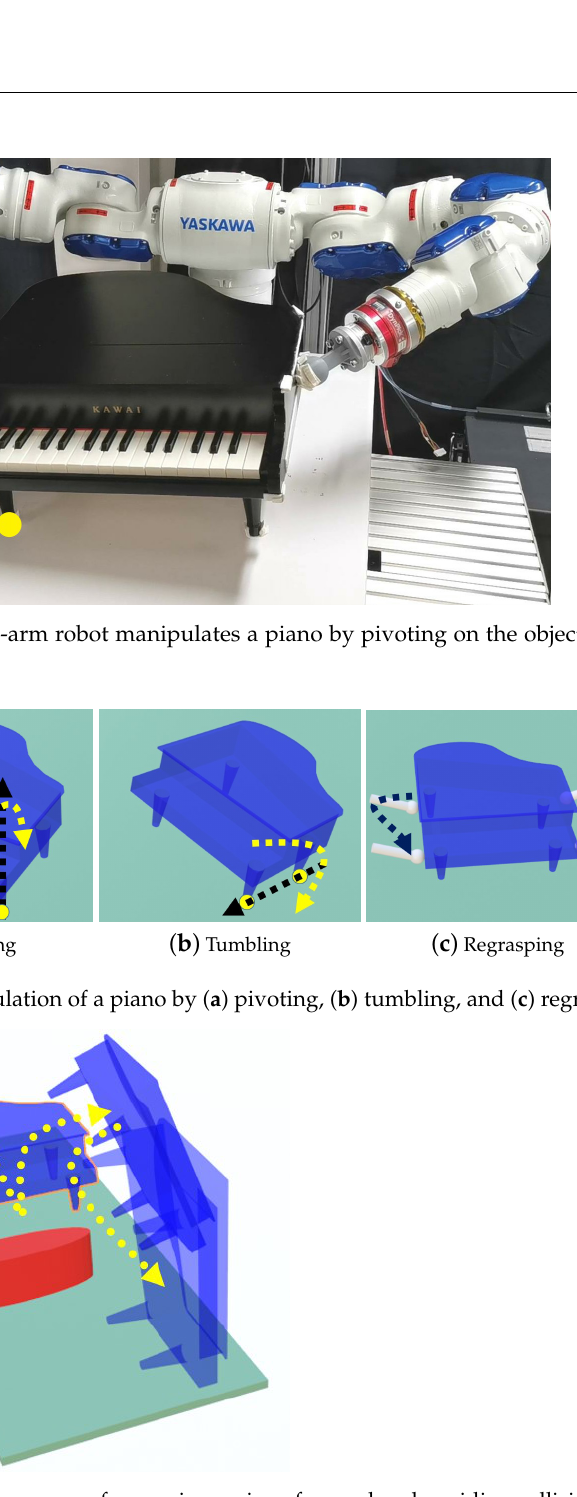
Figure 3. Motion sequence for moving a piano forward and avoiding collision with an obstacle (red colored). Both the initial and goal object poses are in SP, whereas the intermediate object pose is in USP. The yellow trajectory indicates the motion of the object’s